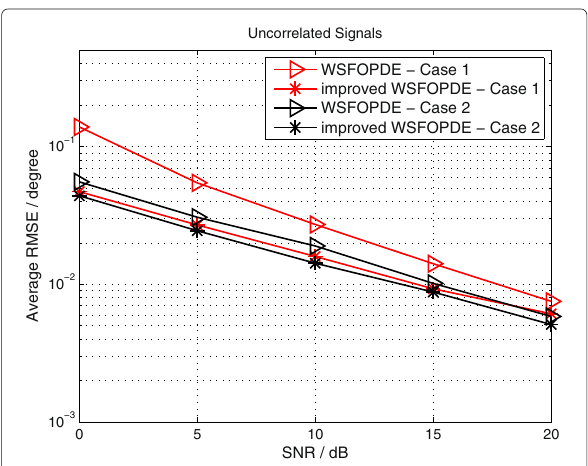
Fig. 9 The RMSE performance with different configuration of M and N : uncorrelated